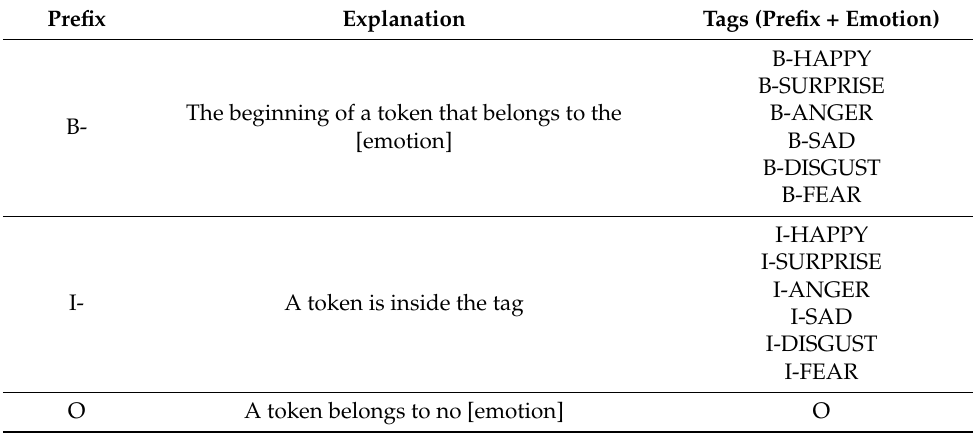
Table 1. BIO-formatted